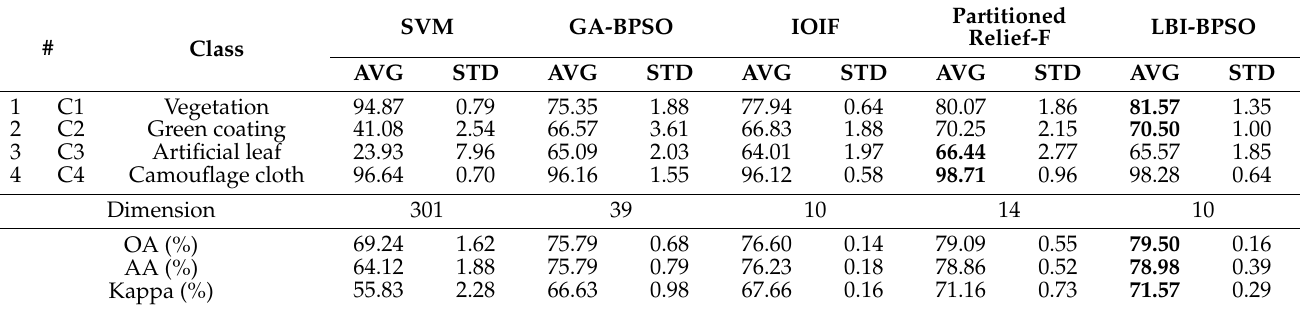
Table 3. Experimental results of simulation data set (SNR =